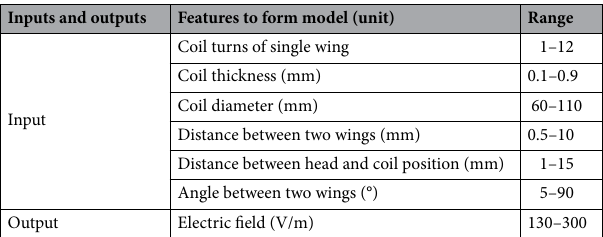
Table 3. Representation of input and output features.